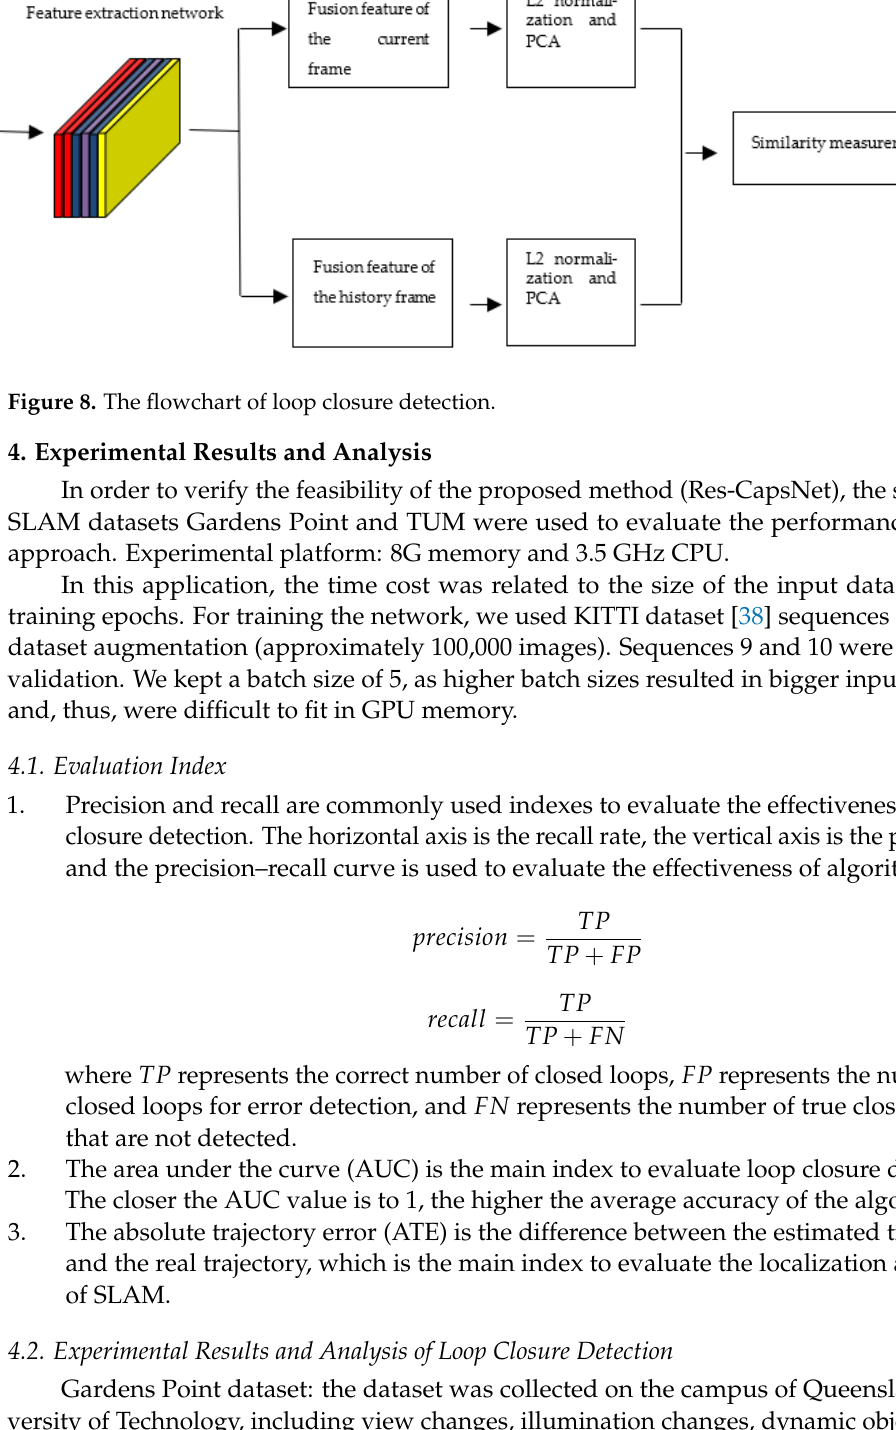
10 of 21 Figure 7. The feature vectors based on the capsule network and the residual network. L2 normalization and principal component analysis (PCA) are used to reduce the